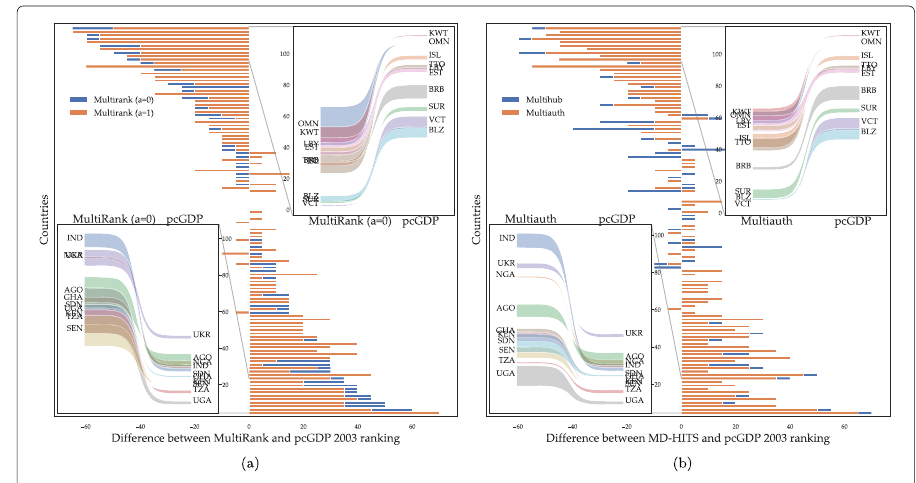
Fig. 9 Difference between ranking of countries by MultiRank ( a ) and MD-HITS ( b ) and by pcGDP in year 2003. The alternative measure for each algorithm is shown in darker color. In the insets only the top and bottom ten countries by rank difference are plotted, with ranking by multiplex centrality on the left and ranking by pcGDP on the right. The width of the line represents the evolution over time of the